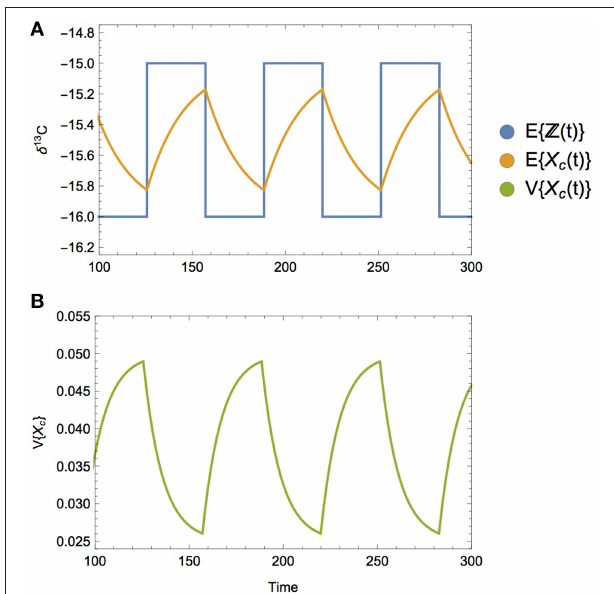
FIGURE 8 | (A) The mean isotopic value of the composite diet over time Z ( t ) when diet-switching is discontinuous, following a square wave pattern, E { } where subdiets have a mean δ 13 C value of mean isotopic value of the consumer over time E change directions when its diet transitions, asymptoting toward (but not reaching) the isotopic mean of its current diet. (B) Consumer isotopic variance follows a similar trajectory over time, asymptoting toward (but not X c ( t ) V { } reaching) the isotope variance of its current diet. When diets follow a discontinuous switching dynamic, the peak variance does not appear at the transition, as it does when the diet switching is